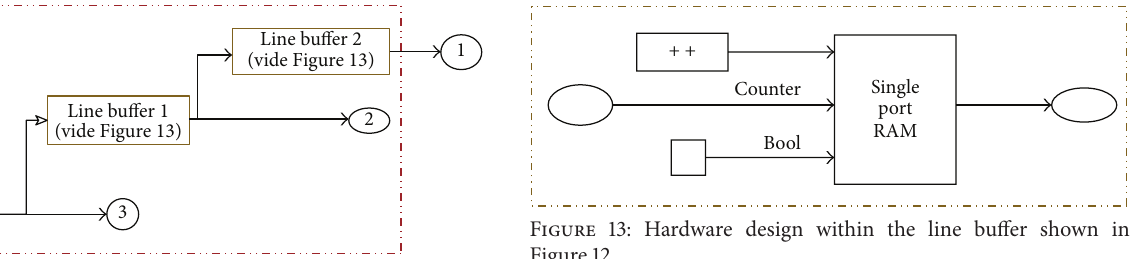
Figure 12: Hardware module showing the line buffering scheme of the pixels as described in Section 5.6 and hardware design (Section 4).